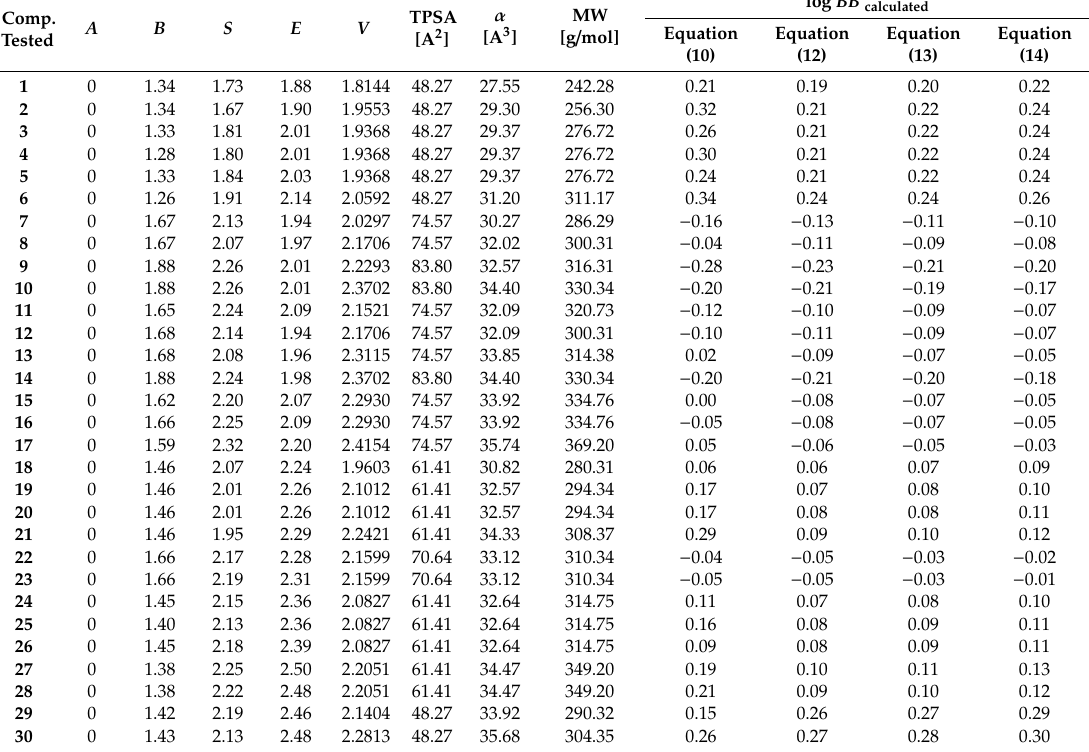
Table 5. Values of A , B , S , E , V , topological polar surface area (TPSA), polarizability ( α ), molecular weight (MW) and log BB of tested compounds. Comp.